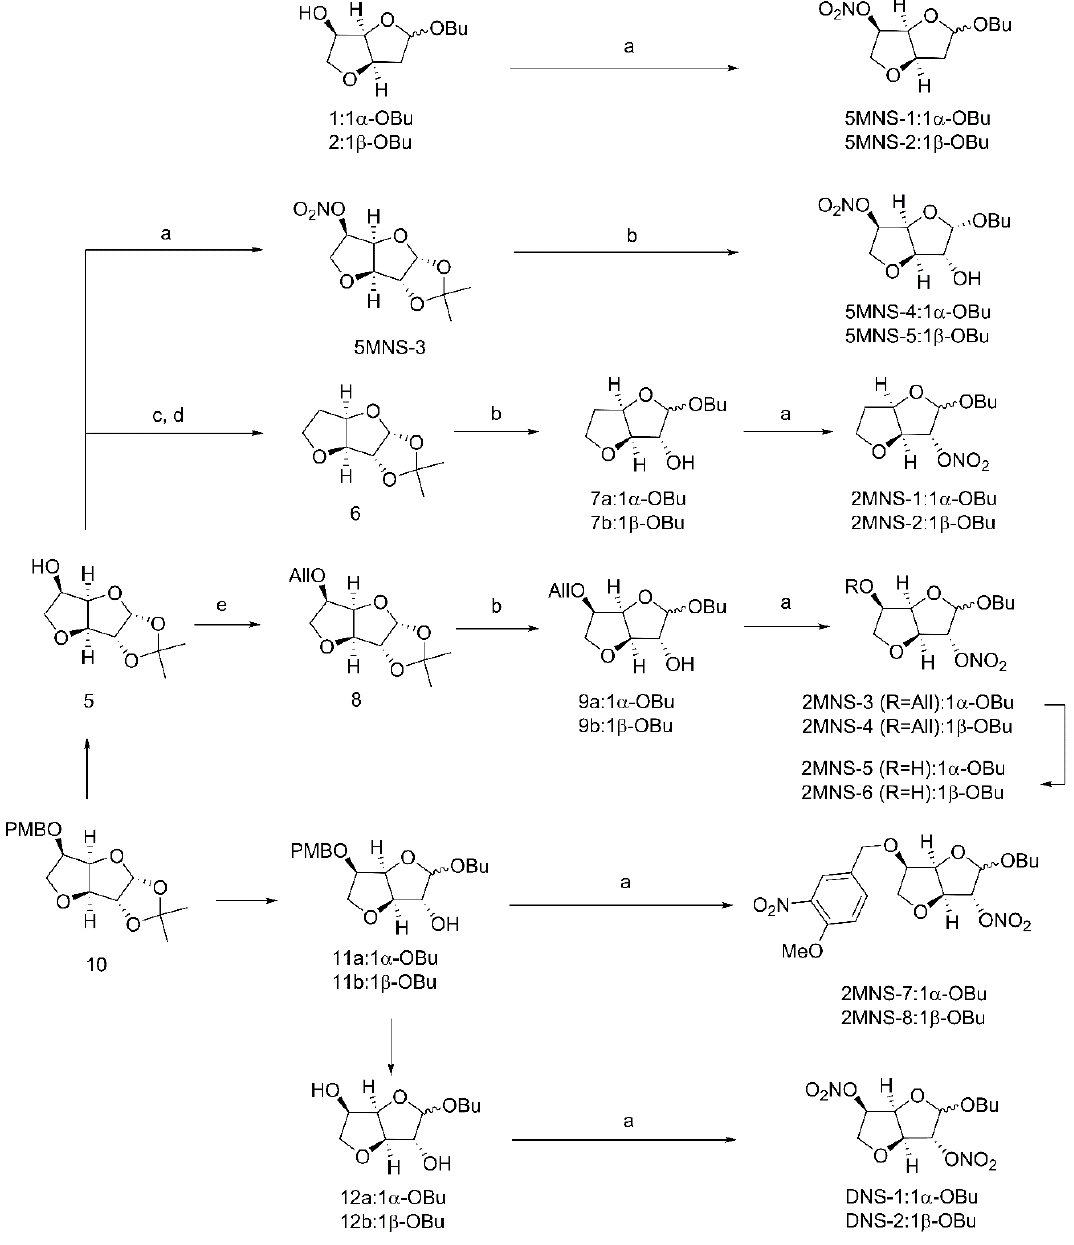
Figure 2. Preparation of nitrate derivatives. Reagents and conditions: ( a ) HNO 3 , Ac 2 O, 0 °C; ( b ) p -TSA, n -BuOH, rt; ( c ) PTC-Cl, DMAP, MeCN, rt; ( d ) AIBN, Bu 3 SnH, toluene, 130 °C; ( e ) 3-bromopropene, NaH, DMF, 0 °C-rt; ( f ) 10% Pd/C, p -TSA, MeOH, 50 °C.